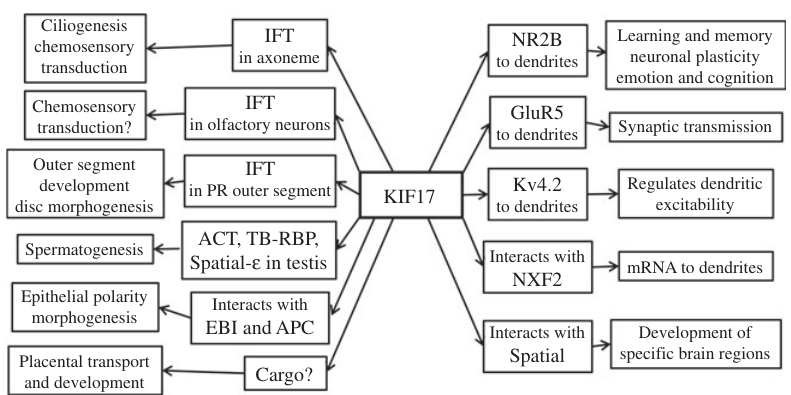
Figure 3 Schematic diagram of diverse functions of KIF17. Radiating from KIF17 are cargos or interactions mediated by this molecular motor. Secondary extensions from the cargos and interactions signify proven or presumed functions resulting from KIF17 transport. See text for